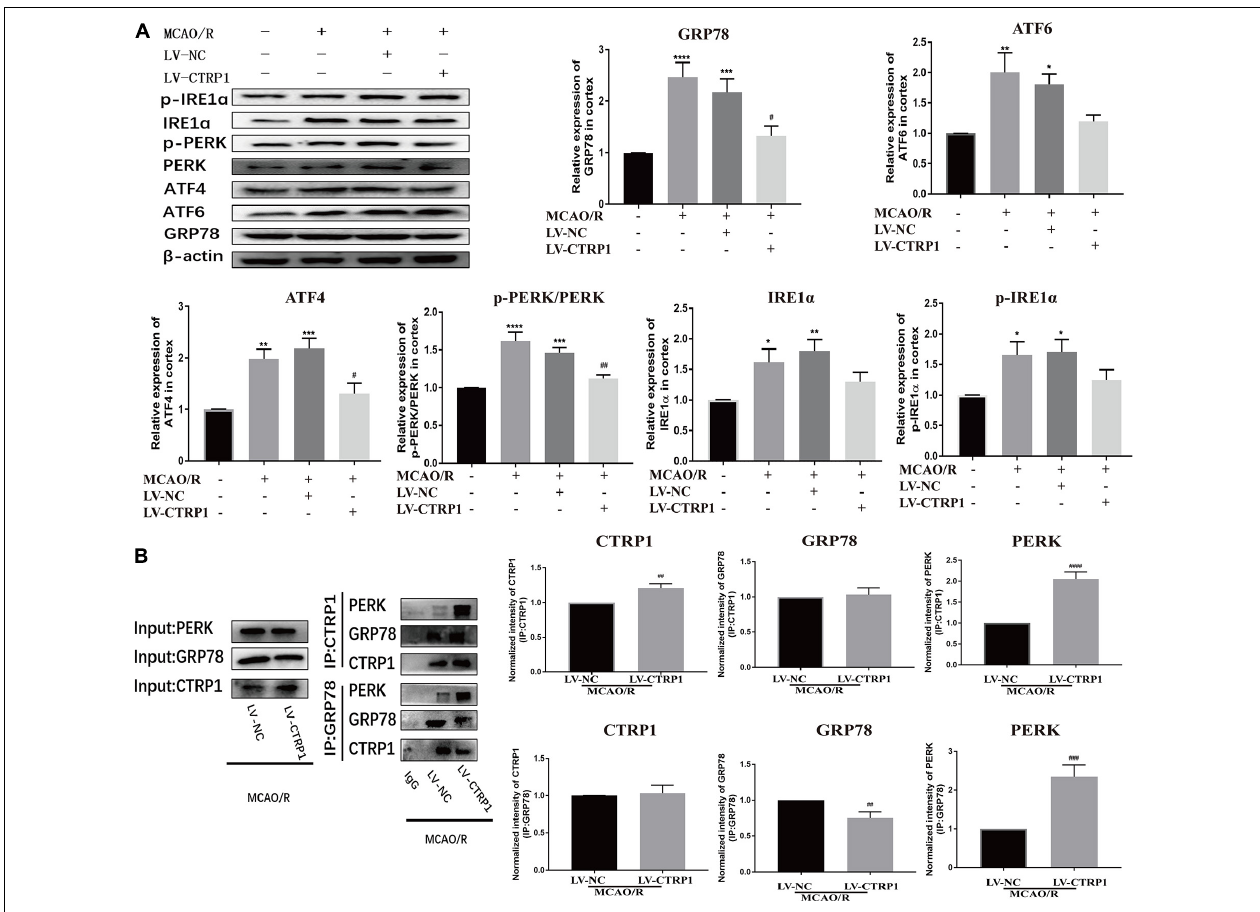
FIGURE 5 | CTRP1 inhibited ERS via PERK signal pathway in the cortex of MCAO/R-treated rats. (A) Western blot analyzed the expression of PERK, p-PERK, GRP78, ATF6, ATF4, IRE1 α , p-IRE1 α . n = 4 per group. (B) CTRP1 affected the interaction between PERK and GRP78 after CIRI. n = 3 per group. **** p <